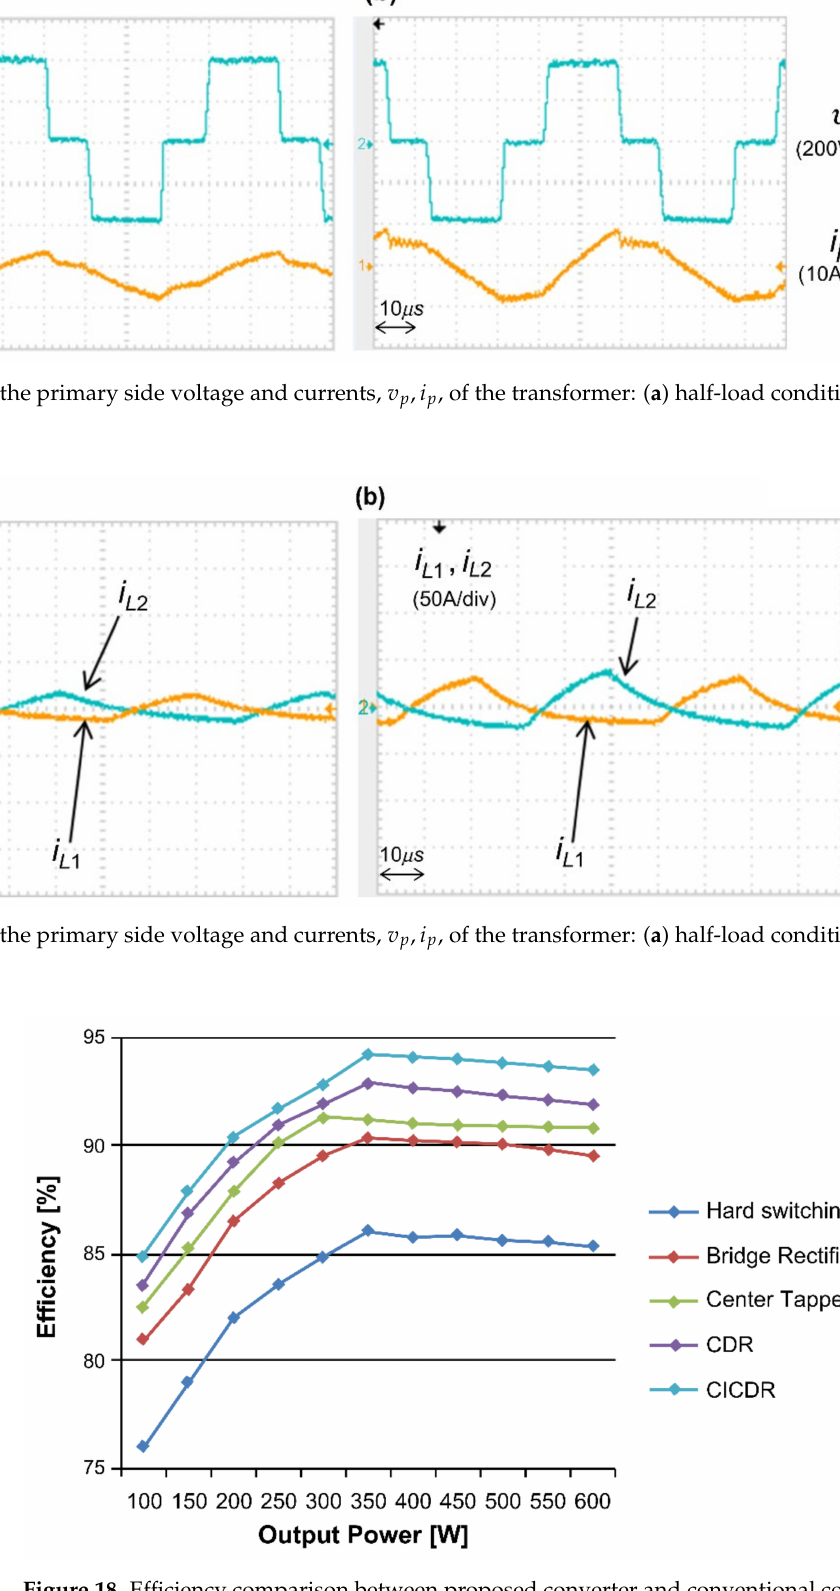
Figure 18. Efficiency comparison between proposed converter and conventional